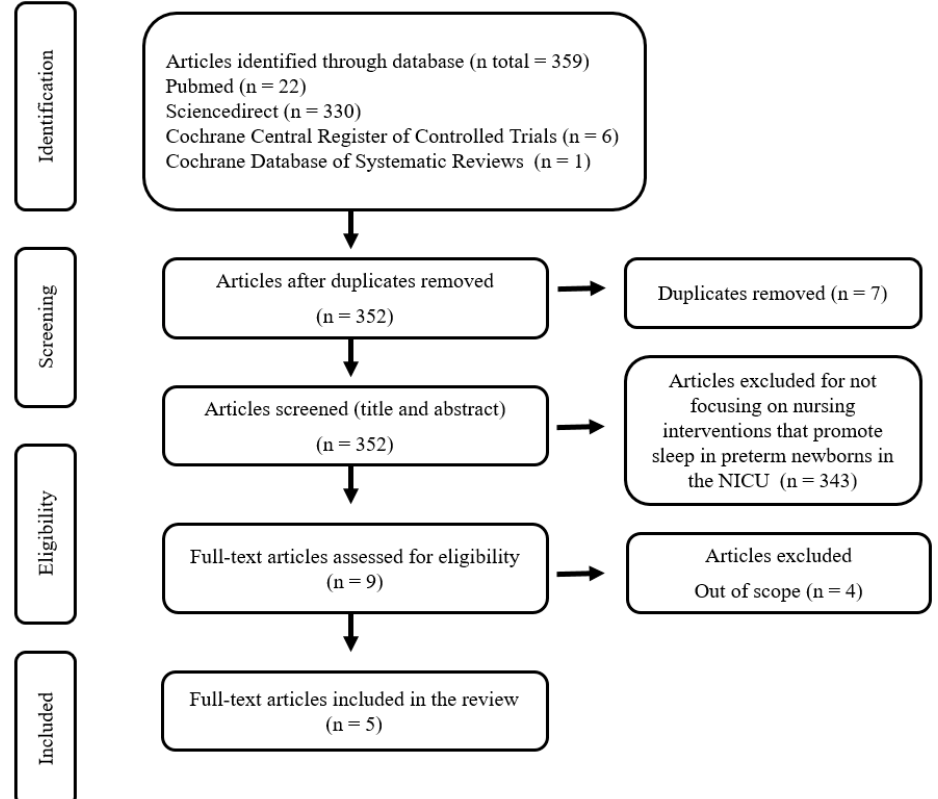
Figure 1. PRISMA flow diagram for study selection.